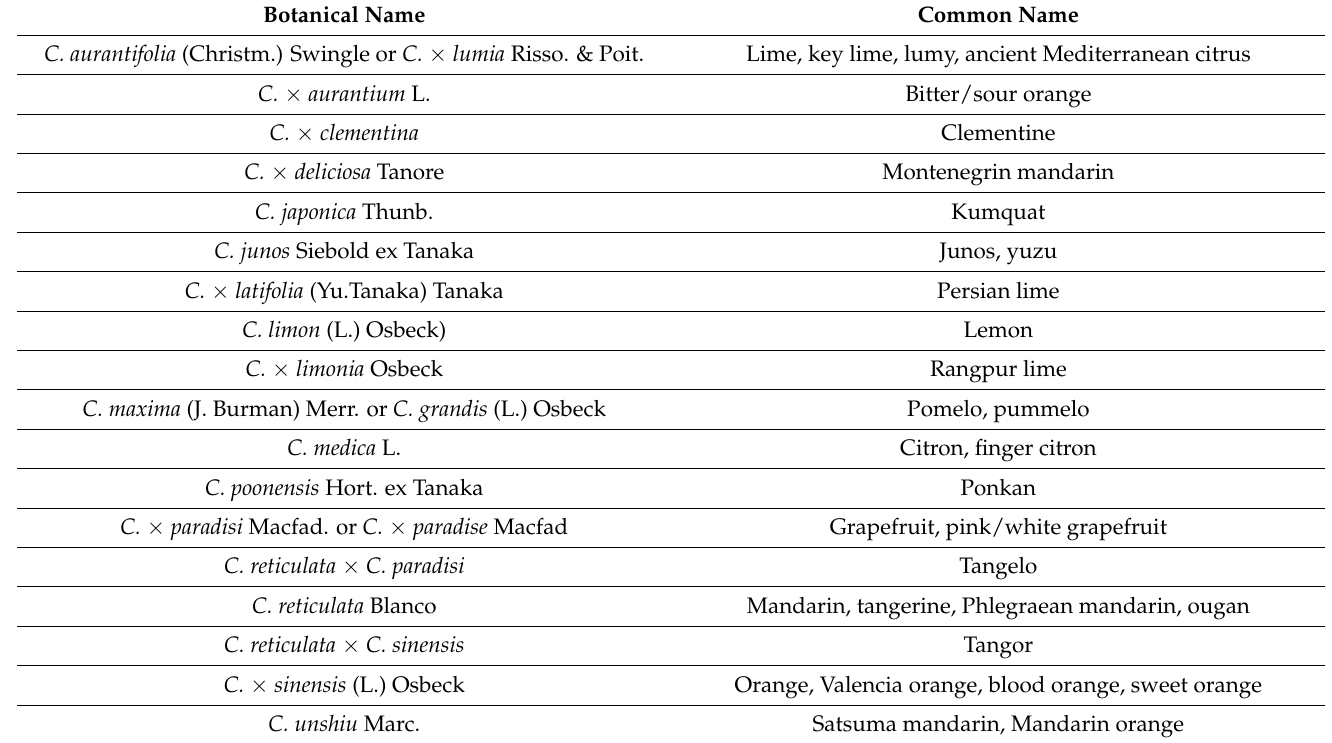
Table 1. The list of citrus fruit species widely investigated for their composition of bioactive com- pounds and their health